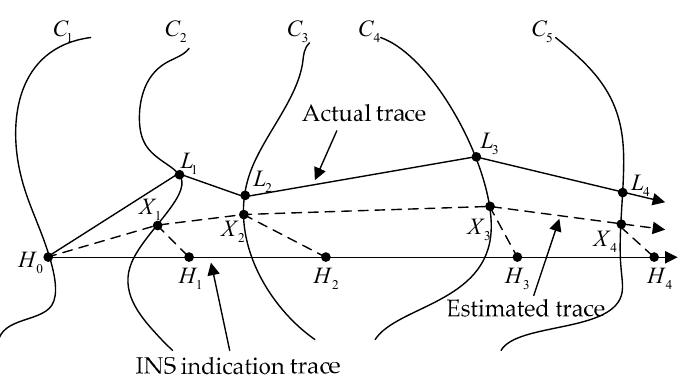
Figure 1. Illustration of inertial navigation system (INS) indication trace, Estimated trace, and Real trace.